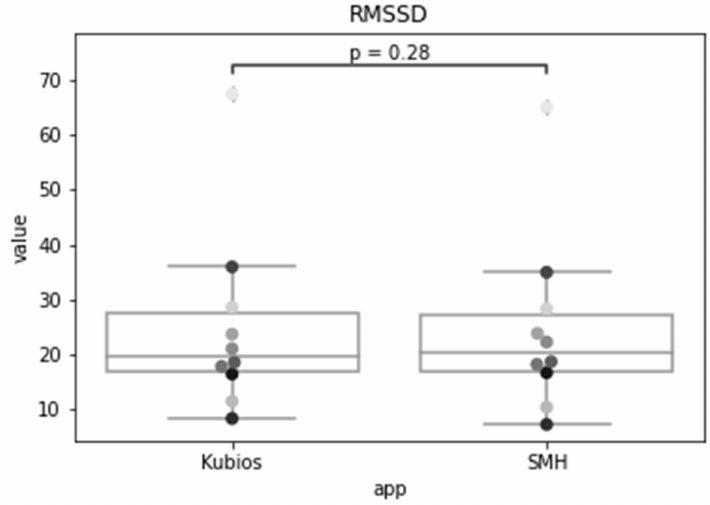
Figure 17. The root mean square of successive differences between normal heartbeats (RMSSD) for Kubios and SMH.